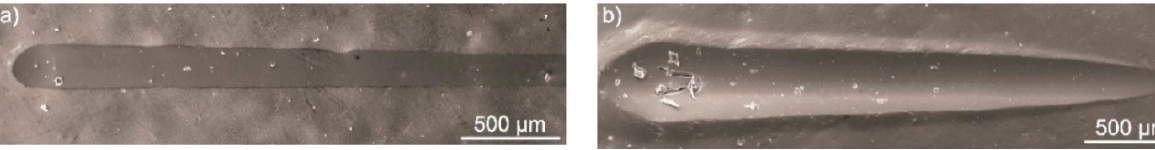
Figure 22. Scratch tracks of the semi-crystalline ( a ) and amorphous ( b ) Si 3 N 4 /PEEK 708 coatings on the Ti-6Al-4V alloy, as per SEM. Reproduced from [106].